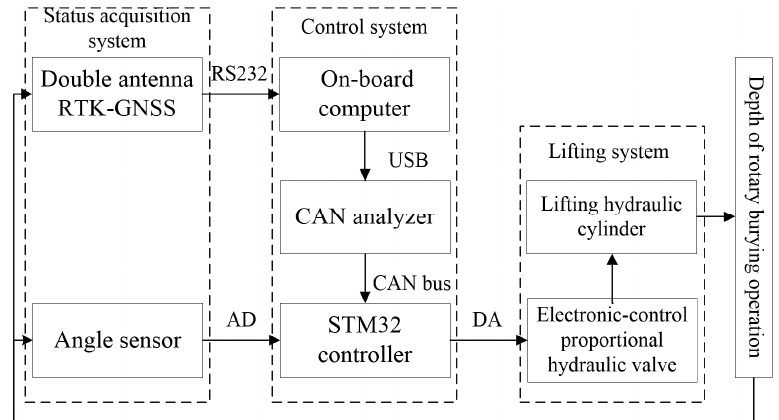
Figure 2. Hardware structure of the rotary burying depth control system.